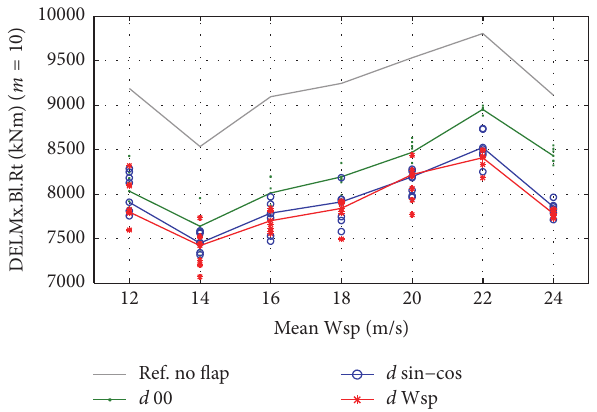
Figure 13: Fatigue damage equivalent loads D L at the blade root flapwise bending moment. The DEL refers to a 25-year lifetime and 10 million equivalent cycles